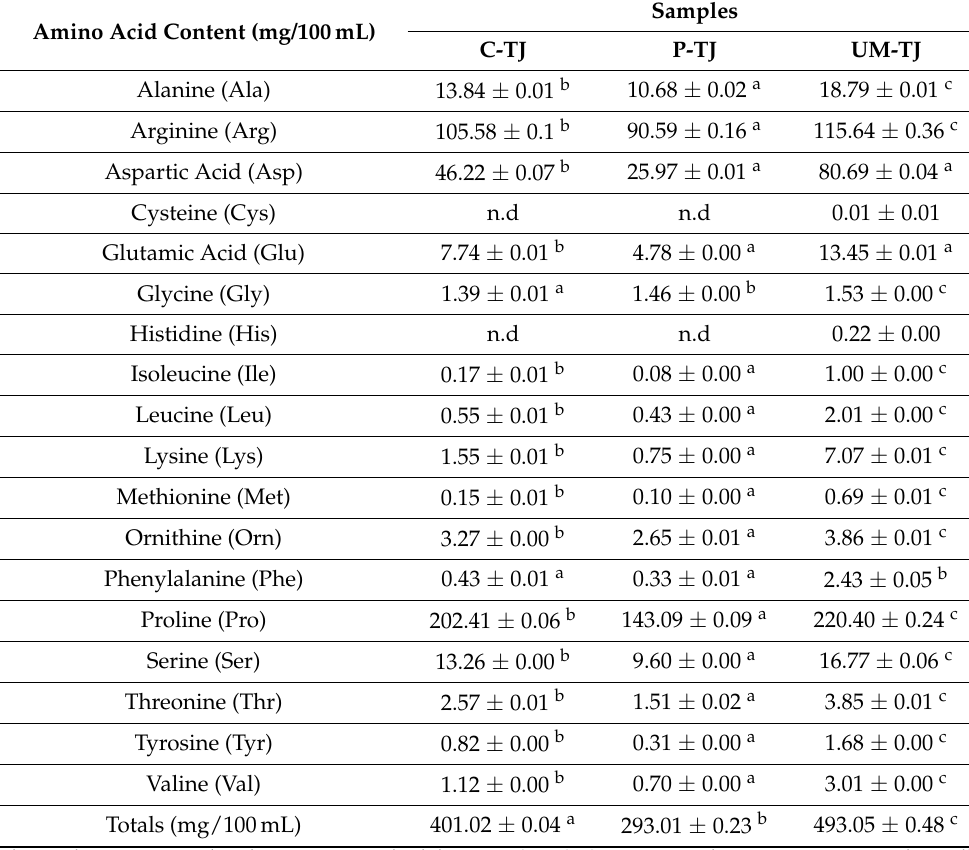
Table 5. Effects of C-TJ, P-TJ, and UM-TJ on free amino acids (mg/100